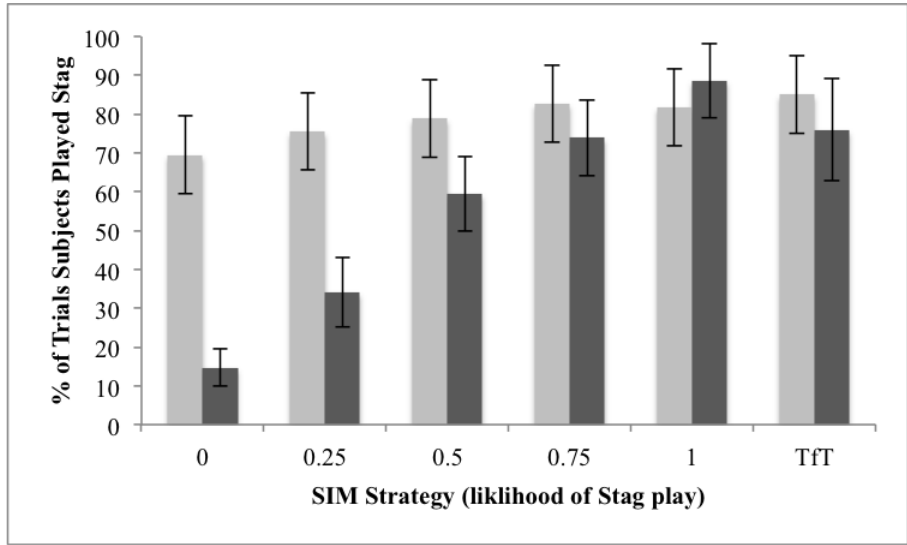
Figure 2 . Mean percentage of trials on which the monkeys (light gray bars) and humans (dark gray bars) selected the Stag response as a function of the SIM strategy with which they were playing. Error bars indicate 95% confidence